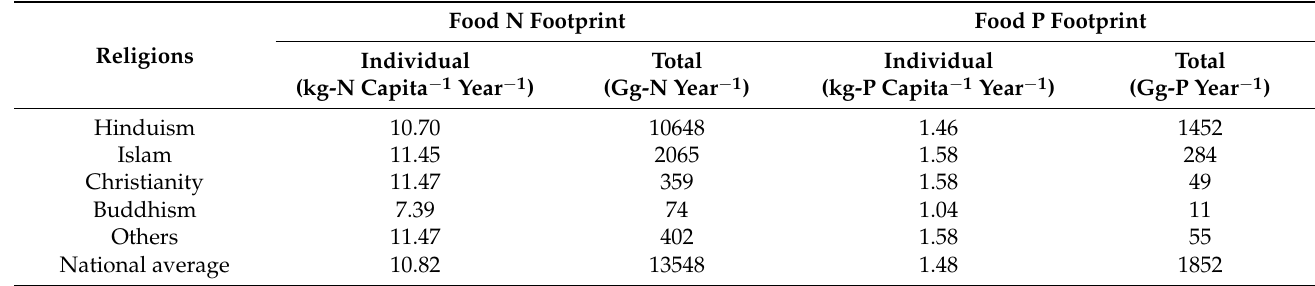
Table 2. Food nitrogen and phosphorus footprints by religion in India in 2013.